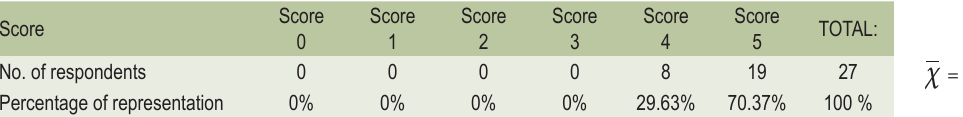
TABLE 6. Condition of respondents after treatment - Acute lumbar pain syndrome